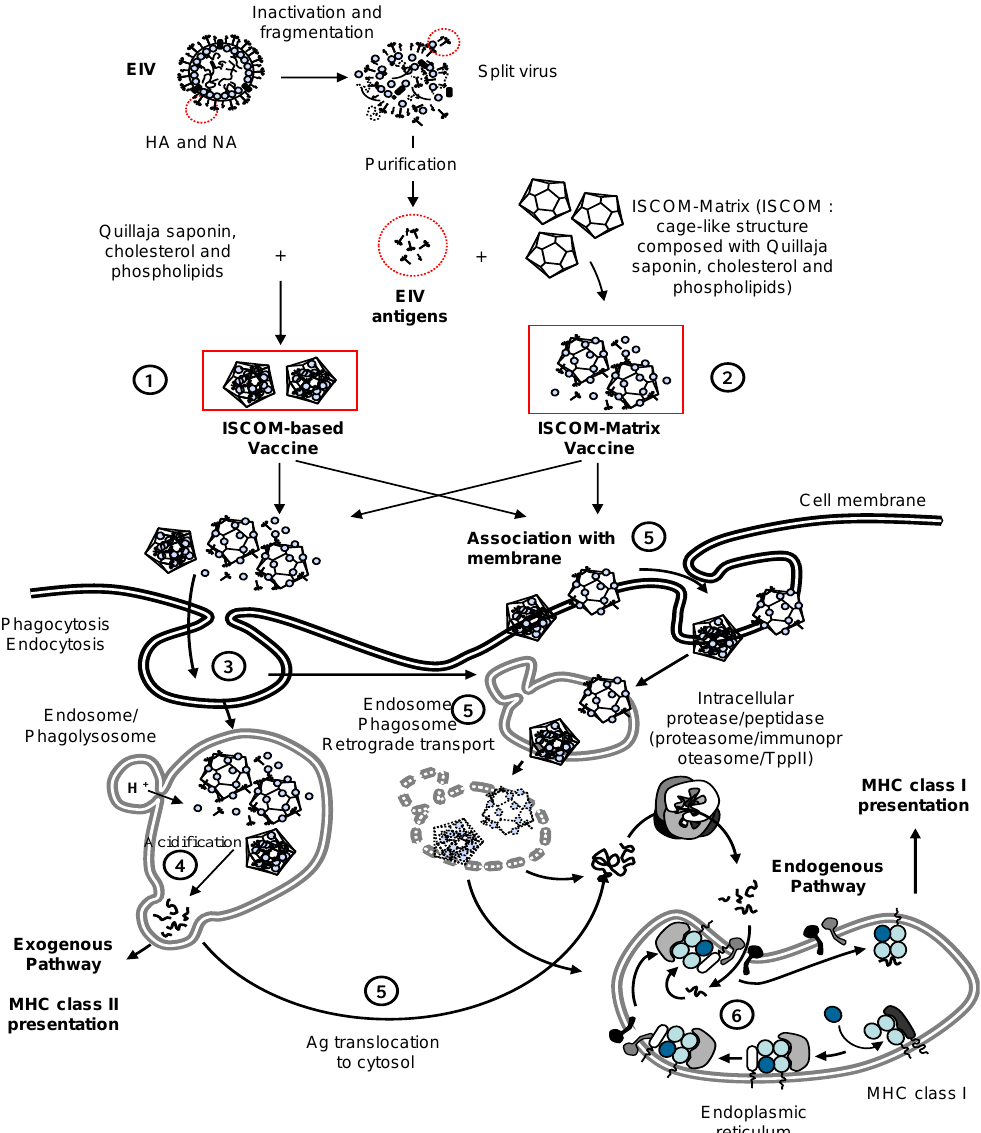
Figure 5. Immuno-Stimulating Complex adjuvanted vaccines (ISCOM) and ISCOM-Matrix vaccine, uptake and major histocompatibility complex (MHC) presentation. Purified EIV antigens (e.g., HA and NA) are directly mixed with Quillaja saponin, cholesterol and phospholipids to produce ISCOM-based vaccine (1) or mixed with preformed ISCOM to produce ISCOM-Matrix-based vaccine (2). Exogenous pathway and antigen presentation by MHC class II molecules. The antigen/ISCOM/ISCOM-Matrix complex is engulfed in phagosomes (3) and enter the exogenous pathwary of antigen presentation after degradation by proteases into short peptides in acidified endosomes (4). The MHC-class II-peptide complex is recognised by the T cell receptor (TCR) of antigen-specific CD4 + T lymphocytes. Cross-presentation of antigen by MHC class I molecules. The antigen/ISCOM/ISCOM-Matrix complex could enter the cell through interaction with the cell membrane, phagocytosis, endocytosis, or similar process (5). The antigens are translocated to the cytosol and reach the endogenous pathway of antigen presentation (6). The complex MHC class I-b2m-peptide is recognised by the T cell receptor (TCR) of an antigen-specific CD8 + T